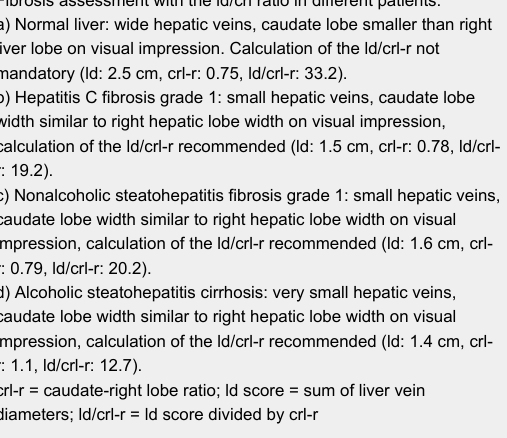
impression, calculation of the ld/crl-r recommended (ld: 1.4 cm, crl- r: 1.1, ld/crl-r: 12.7). crl-r = caudate-right lobe ratio; ld score = sum of liver vein diameters; ld/crl-r = ld score divided by